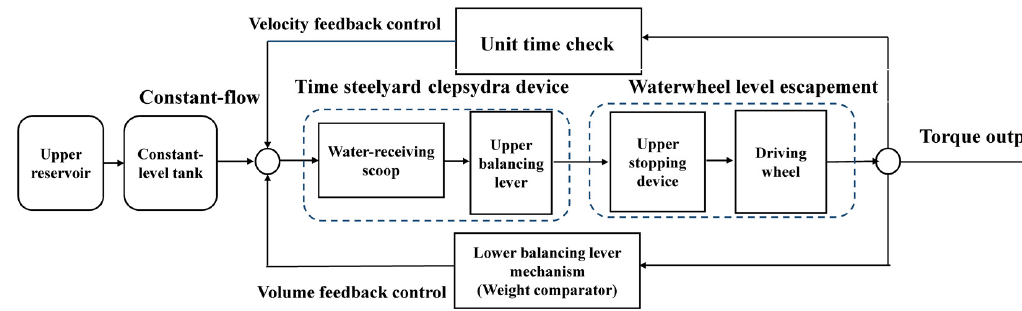
Figure 9. Kinematic model of the waterwheel steelyard clepsydra